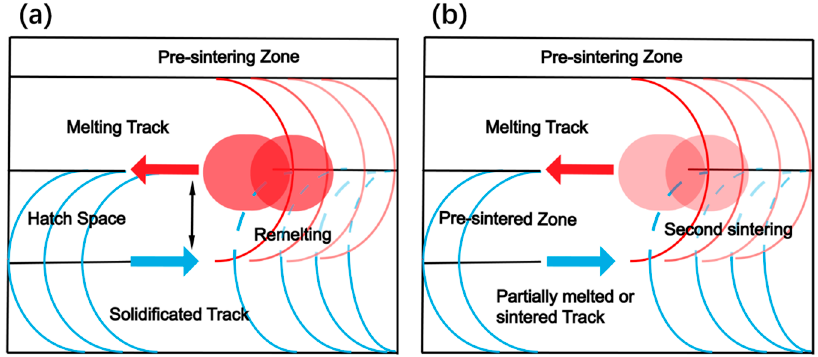
Figure 6. Schematic diagram of the formation mechanism of melted dense layer at two track for- mation modes: ( a ) stable melting mode, ( b ) lack of energy mode.